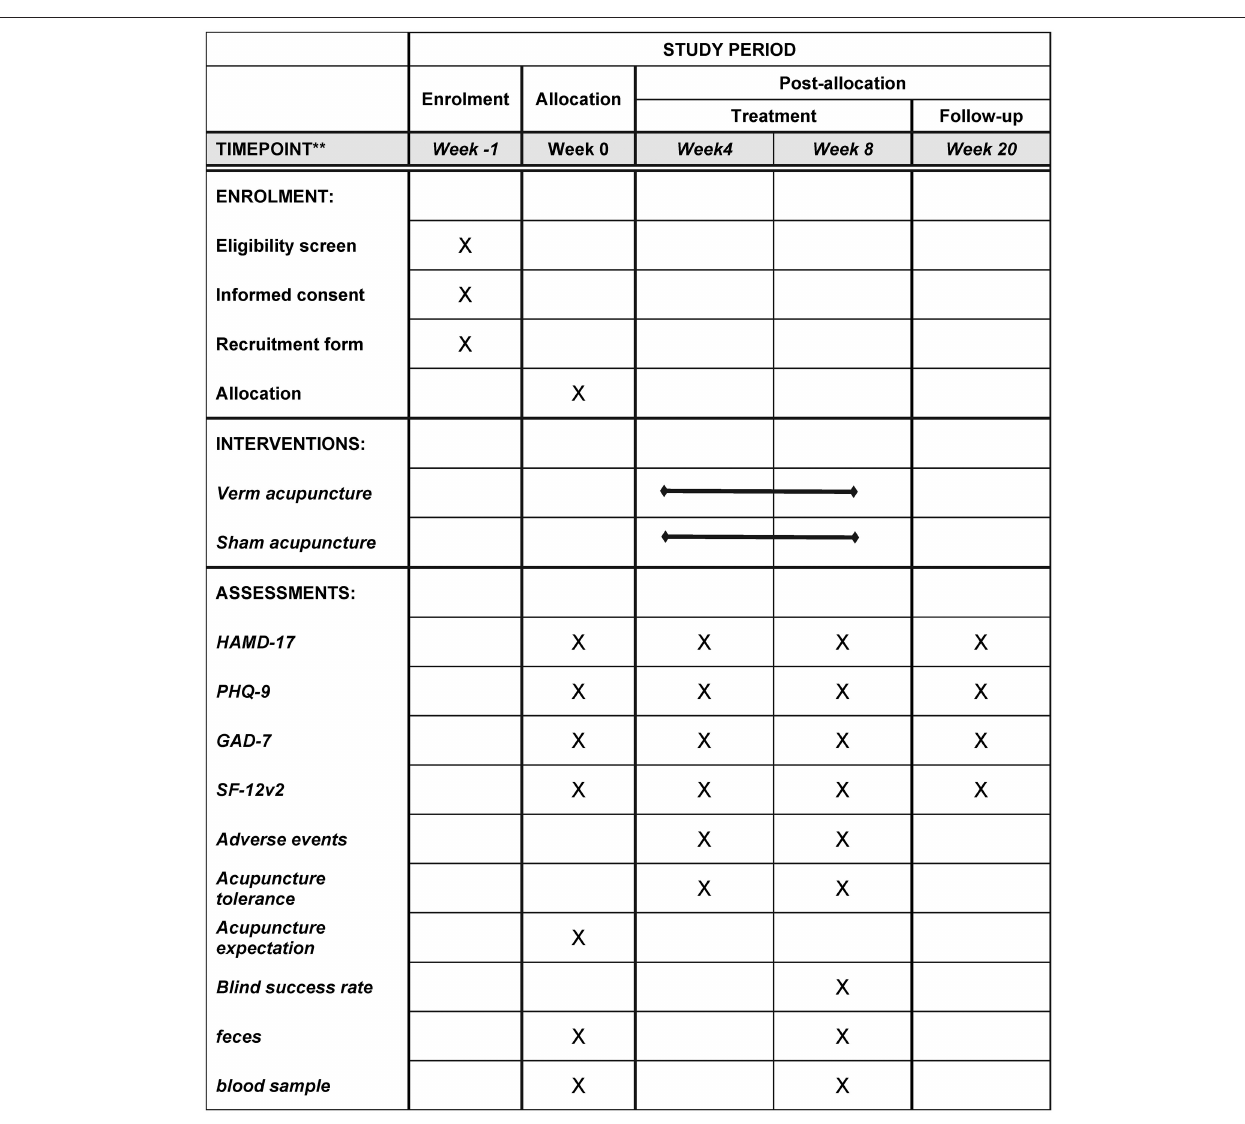
than 2 h (VAS ≥ 4), local hematoma, infection, or abscess. Other unforeseen adverse events will be recorded at all trial